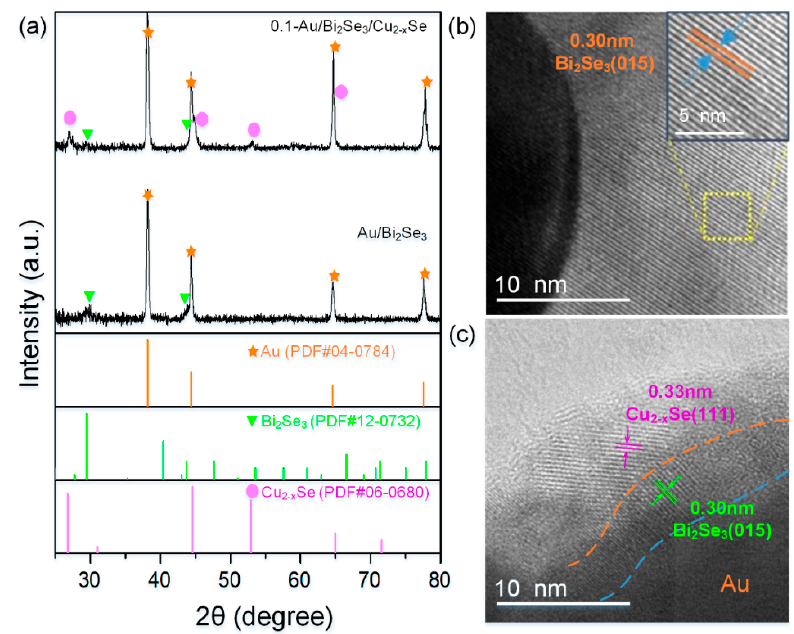
Figure 2. ( a ) XRD spectra of Au/Bi 2 Se 3 and Au/Bi 2 Se 3 /Cu 2 − x Se nanoparticles. Corresponding HRTEM images of individual ( b ) Au/Bi 2 Se 3 and ( c ) Au/Bi 2 Se 3 /Cu 2 − x Se nanoparticles at their interfaces. The white arrows indicate the regions of nanopores.